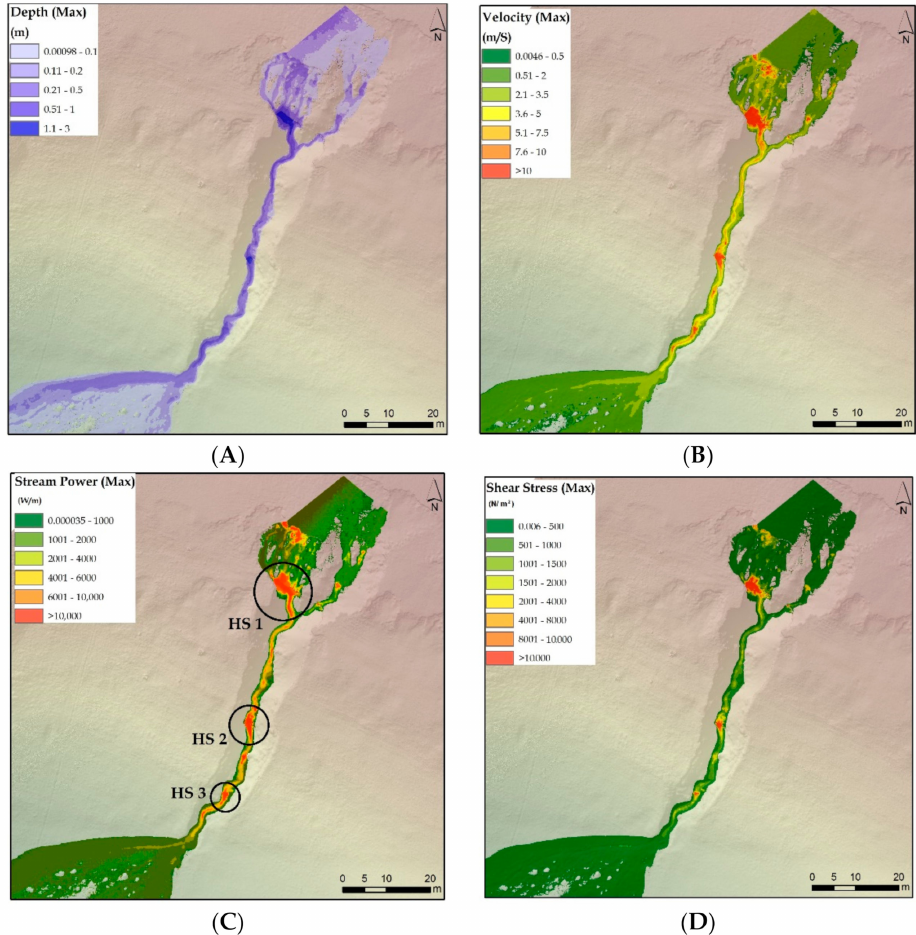
Figure 8. ( A ) Maximum depth; ( B ) velocity; ( C ) stream power; ( D ) shear